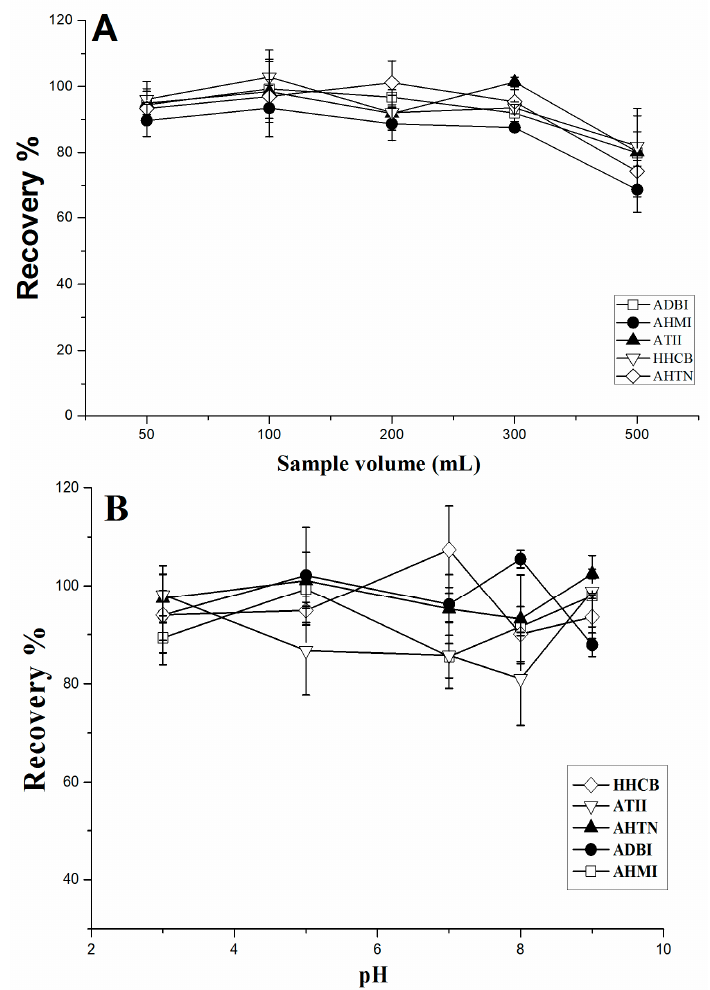
Figure 4. Effect of ( A ) sample volume and ( B ) solution pH on SPE efficiency.